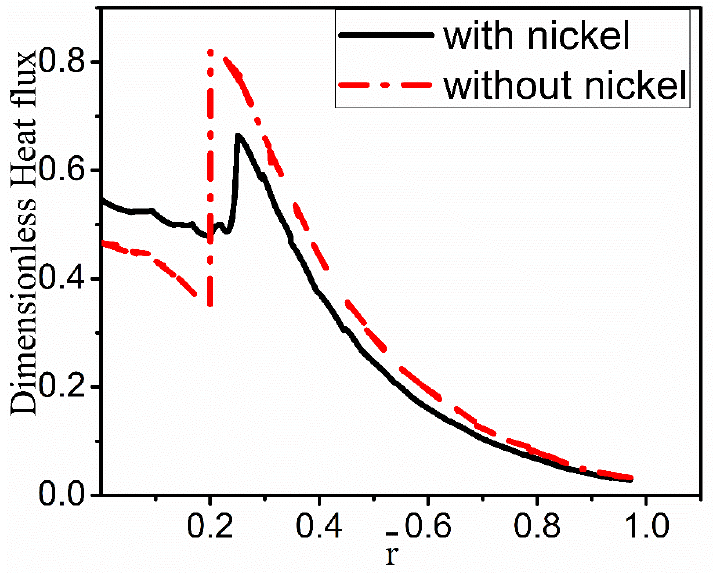
Figure 7. Dimensionless heat flux with and without nickel coating at z(cid:3364) = 0.1.